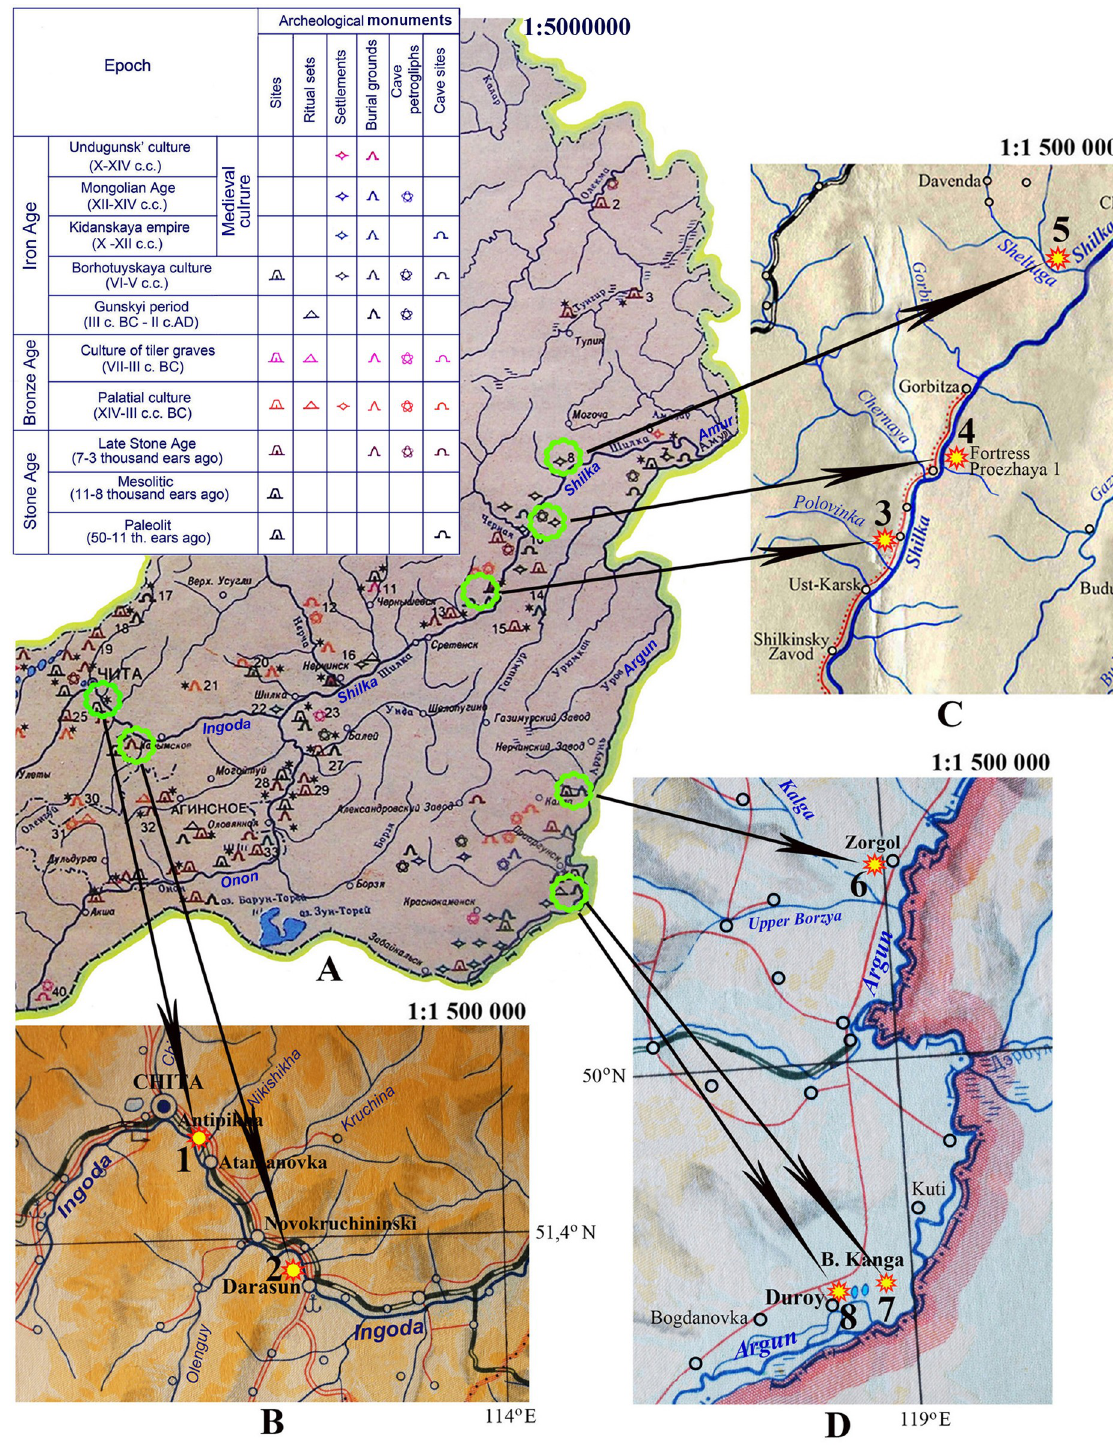
Fig 1. A– Archaeological map of Transbaikalia [32]; archaeological sites and monuments are designated by circles, sampling sites of shells–by numbers. B1 –Chita district, Antipikha settlement, Ingoda River high-water bed, drill hole; B2 –Karymsk district, Darasun settlement, ancient site. C –Sretensk district: 3 – ancient Luzhanki settlement, 4 – fortress Proezzhaya 1, 5 – ancient settlement by Zheltuga River. D – Priargunsk district: 6 –Zorgol burial, 7 – Bol’shaya Kanga ancient settlement 2; 8 – Duroy 6